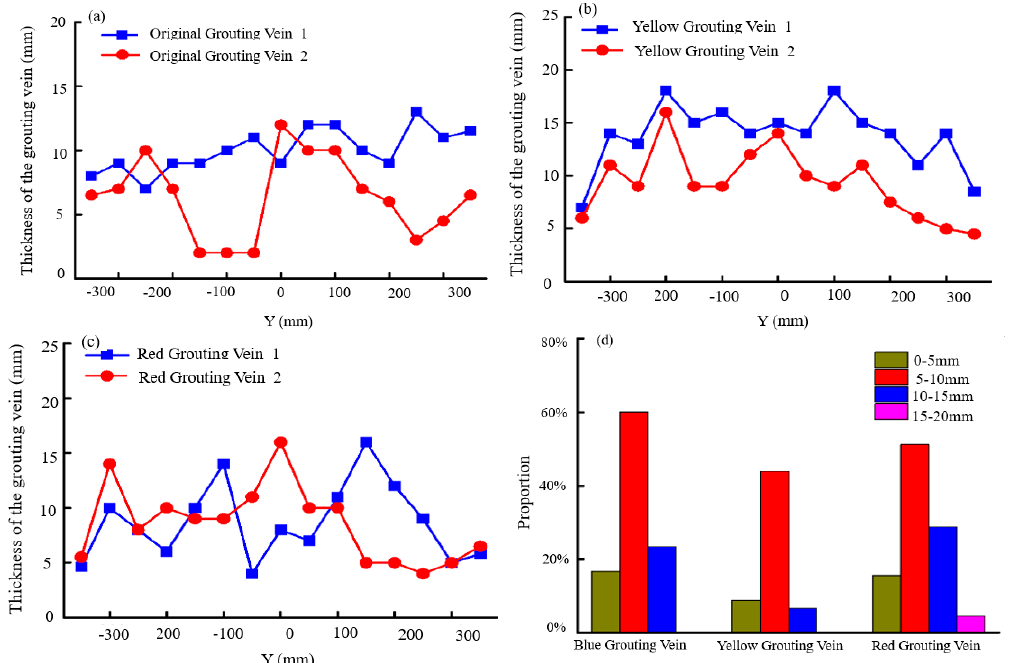
Figure 9. Thickness distribution of the grouting veins in the B (400 mm) section: ( a ) thickness distribution of the original grouting vein; ( b ) thickness distribution of the yellow grouting vein; ( c ) thickness distribution of the red grouting vein; and ( d ) thickness distribution proportions of the different grouting veins.